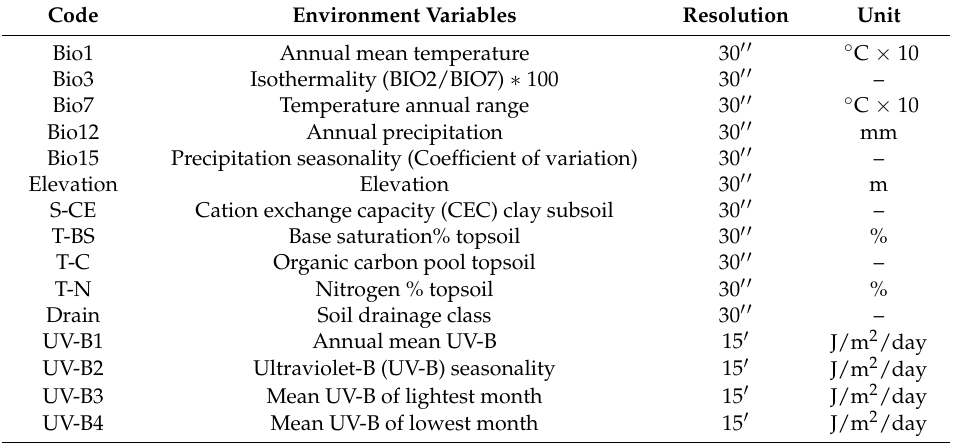
Table 1. Environmental variables used to predict the geographical distributions of Salicaceae